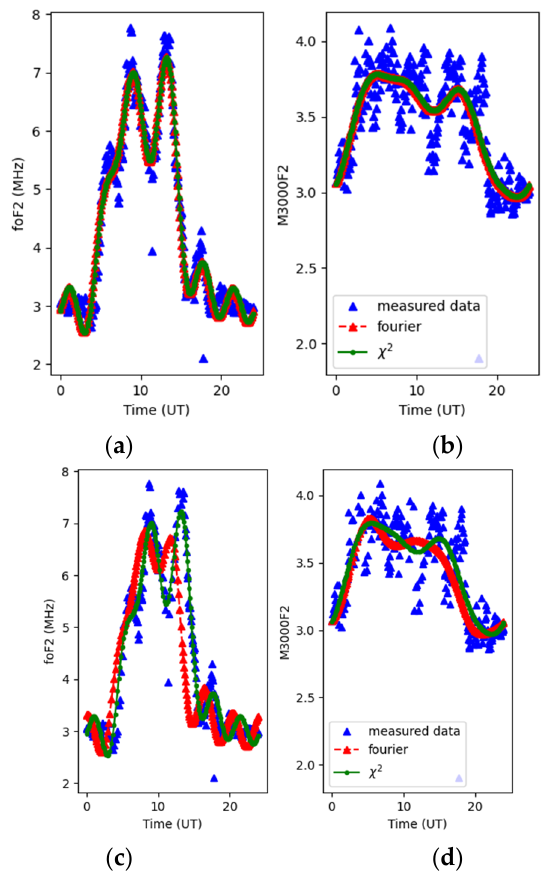
Figure 5. CCIR polynomials estimated using χ 2 minimization (green) and Discrete Fourier transform (red) from auto-scaled values of foF2 and M(3000)F2 for the case of no data gaps ( a , b ) and after removing the equivalent of 3 h of data ( c , d ).